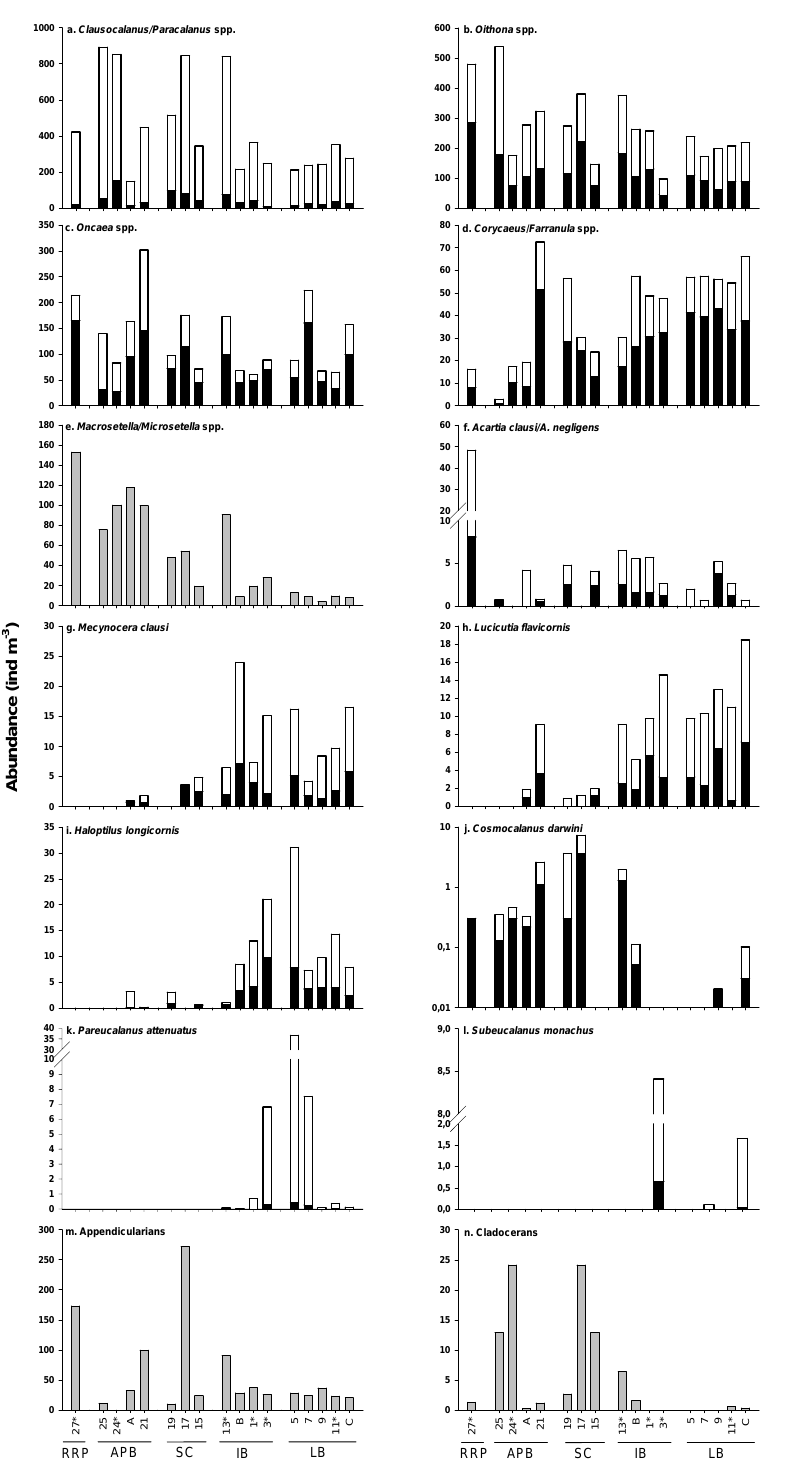
Fig. 3. Spatial distribution of the important zooplankton species across the Mediterranean transect: (a) Clausocalanus spp. and Paracalanus spp., (b) Oithona spp., (c) Oncaea spp., (d) Corycaeus spp. and Farranula spp., (e) Macrosetella spp. and Microsetella spp., (f) Acartia clausi and Acartia negligens , (g) Mecynocera clausi , (h) Lucicutia flavicornis , (i) Haloptilus longicornis , (j) Cosmocalanus darwini , (k) Pareucalanus attenuatus , (l) Subeucalanus monachus , (m) Appendicularians and (n) Cladocerans. Copepodit (white), adult (black) and undifferentiated (grey) stages. ( ∗ ) night sampling. Mean for stations A, B and C between day and night sampling. Note: logarithmic scale in panel (j)